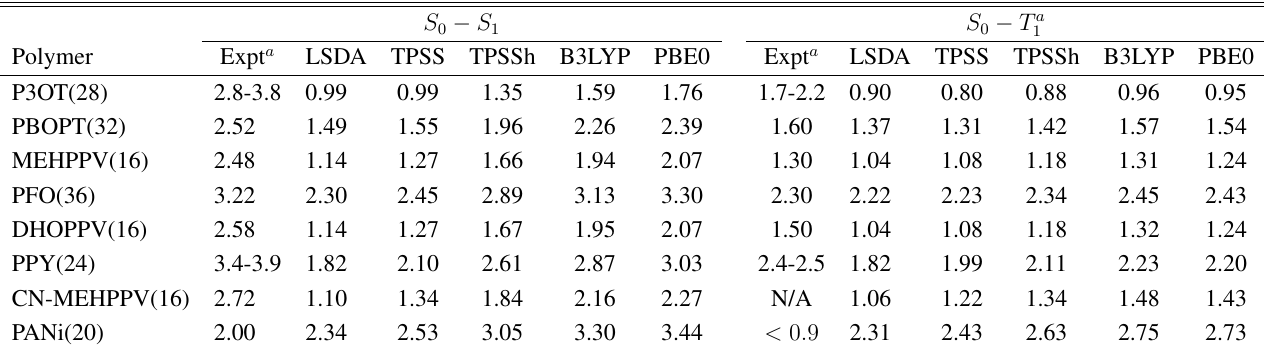
Table 19. Excitation energies of singlet-singlet ( S gaps (in units of eV) of polymers of length of ∼ 10 nm in gas phase calculated using the adiabatic TDDFT methods with the ground-state geometries optimized on the respective density functionals. Basis set 6-31G is used in all calculations. The number in parentheses is the number of rings included in our calculations. 1 hartree = 27.21